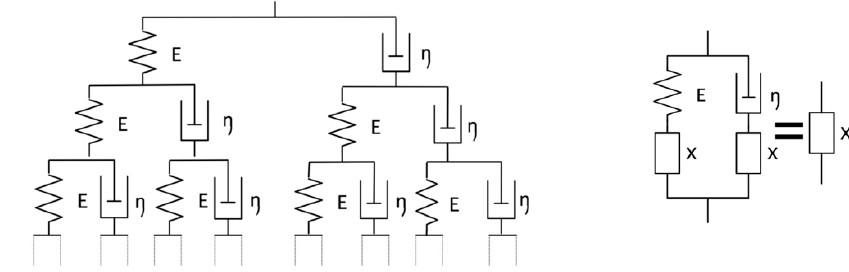
Figure 3. Fractal network and equivalent system.